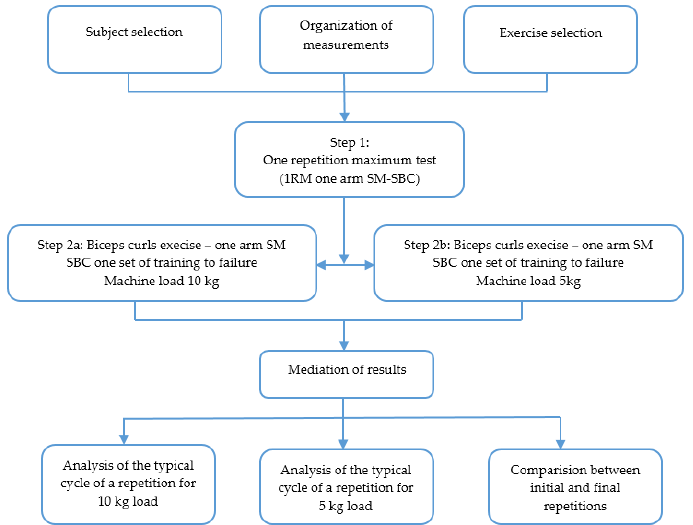
Figure 2. The flow chart of the experimental methodology based on two steps.